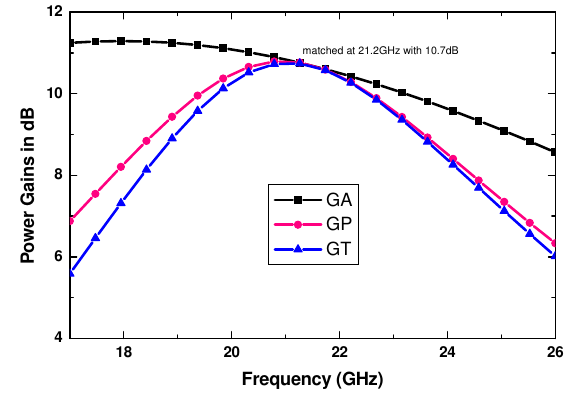
Figure 4. Power gains for the amplifier core and the matched LNA (without